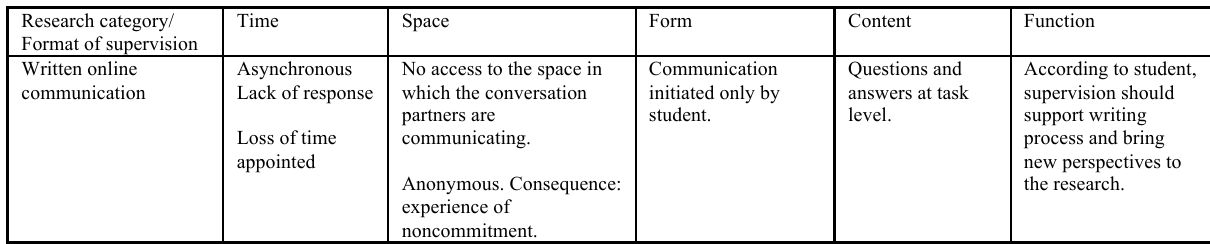
Table 8: Findings concerning Siv’s experience of various online